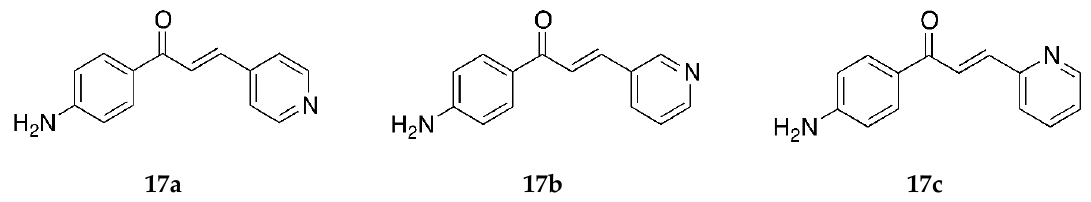
Figure 14. Chemical structures of 4-aminochalcone derivates containing pyridine rings.